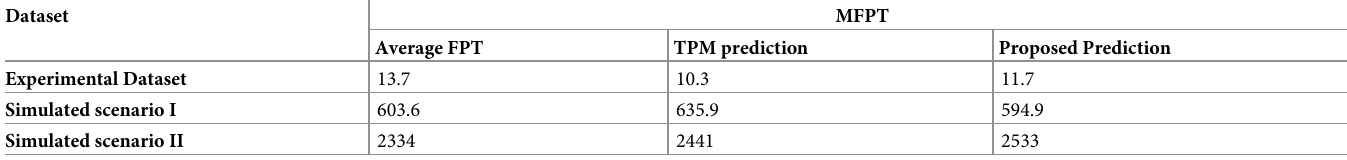
Table 1. Predictions using the proposed method to calculate MFPT to failure compared with numerical first passage time (FPT) averages and predictions using the TPM method. Comparisons are presented for the experimental data-set and two simulated scenarios with [ m ¼ N ð 0 : 45 ; 0 : 08 2 Þ and Z ¼ N ð 0 : 6 ; 0 : 1 2 Þ ] and [ m ¼ N ð 0 : 45 ; 0 : 07 2 Þ and Z ¼ N ð 0 : 6 ; 0 : 1 2 Þ ]